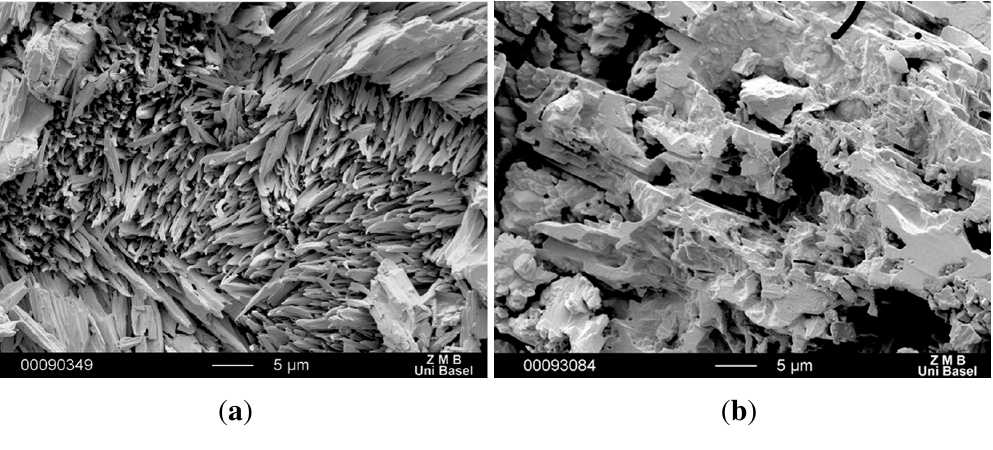
Figure 8. SEM picture of compact surface of untreated CBZ ( a ) and of recrystallized CBZ ( b ) after 8 h DIDR